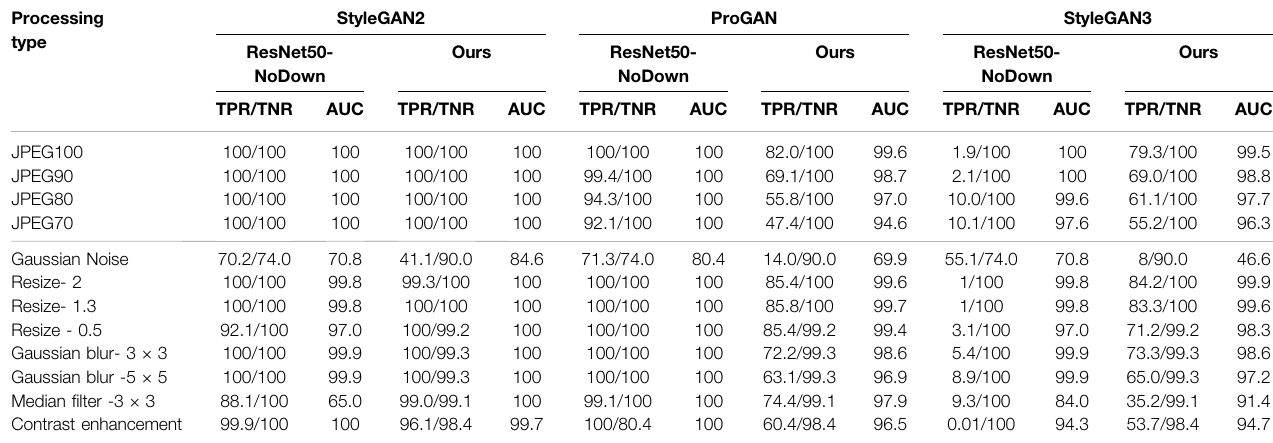
TABLE 3 | TPR/TNR (%) and AUC (%) of the proposed method and the baseline under various image processing operations. Tests are carried out in matched (StyleGAN2) and mismatched (ProGAN and StyleGAN3)